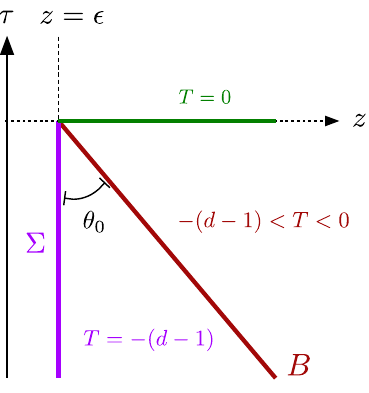
Figure 3 . The brane B interpolates between the boundary Σ at T = − ( d − 1) and the τ = 0 time slice at T = 0 . The angle θ 0 between B and Σ is given by θ 0 = arcsin